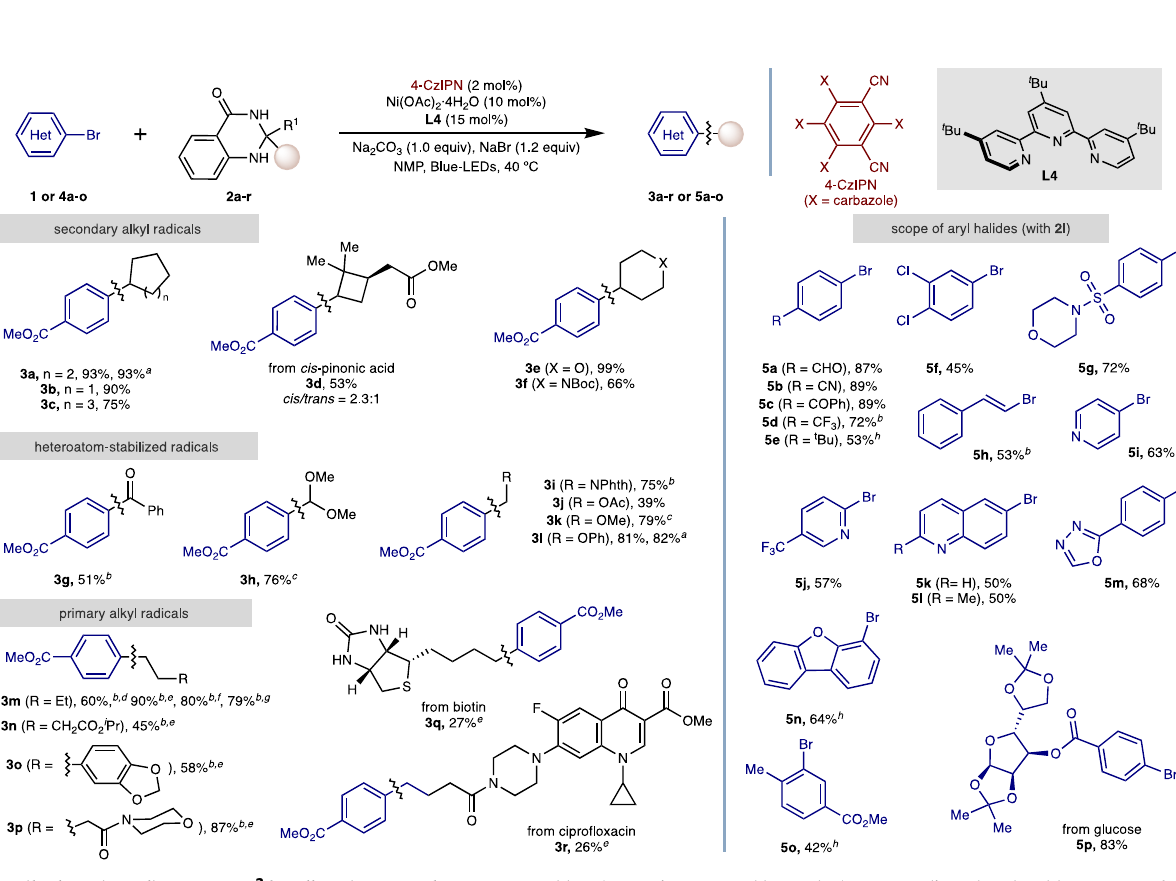
Fig. 2 Dihydroquinazolinones as sp 3 handles via a C – C cleavage. As Table 1 (entry 1), using aryl bromide (0.20 mmol). Isolated yields, average of at least two independent runs. Unless stated otherwise, R 1 = Me in the ketone derivative. a R 1 = Et in the ketone derivative. b Using NiCl 2 ·DME as Ni source in NMP (0.2 M). c Using 5-CzBN (2 mol%) as photocatalyst, LiBr (1.2 eq.) as additive. d 1 H NMR yield using CH 2 Br 2 as standard. e R 1 = Ph in the ketone derivative. f R 1 = 4-methoxyphenyl in the ketone derivative. g R 1 = benzo[d][1,3]dioxol-5-yl in the ketone derivative. h Aryl bromide (0.20 mmol), ketone